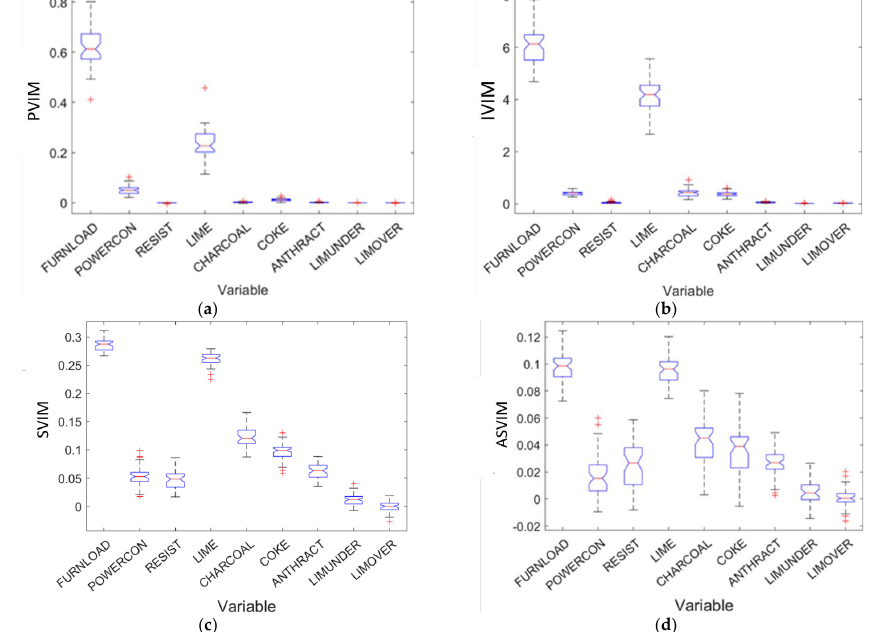
Figure 5. Relative importance of predictors in Case Study 2 based on 50 runs, showing ( a ) permutation indices (R 2 on test data), ( b ) impurity indices (on OOB data), ( c ) Shapley values (R 2 on test data), and ( d ) approximate Shapley values (R 2 on test data).